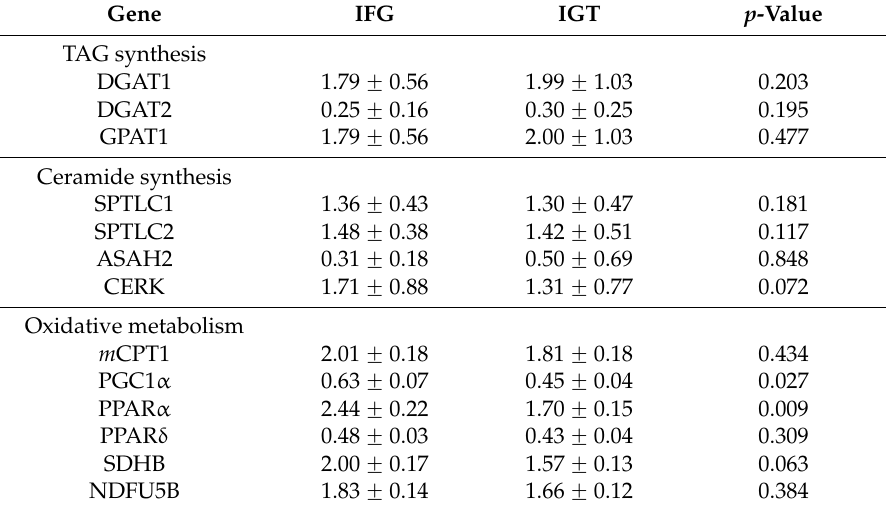
Table 5. Fasting skeletal muscle gene